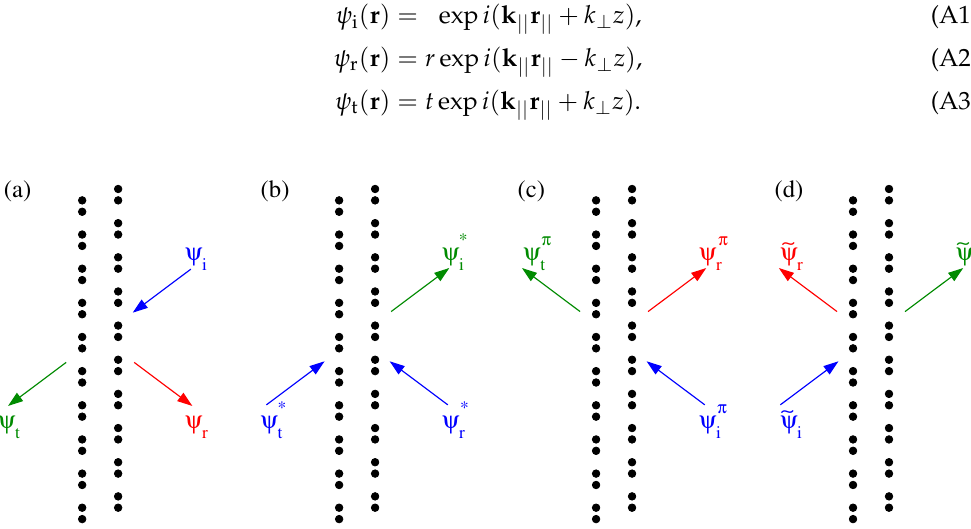
Figure A1. Electron-scattering from an inversion-symmetric bilayer. ( a ) Scattering wave function at some k || : incident ψ i , reflected ψ r , and transmitted wave ψ t . ( b ) Time-reversed wave function. ( c ) Scattering wave function at − k || : the electron source of graph ( a ) is rotated by π around the surface normal. ( d ) Spatially inverted wave